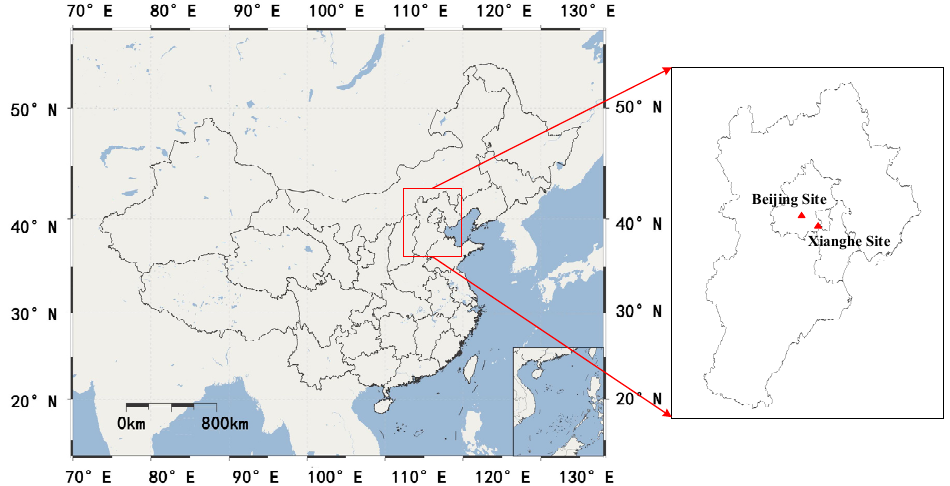
Figure 1. Geographical locations of the study areas as shown on a map of China ( left ) with the Beijing–Tianjin–Hebei region highlighted on the ( right ). The two aerosol robotic network sites marked by red triangles are the Beijing and Xianghe Sites.